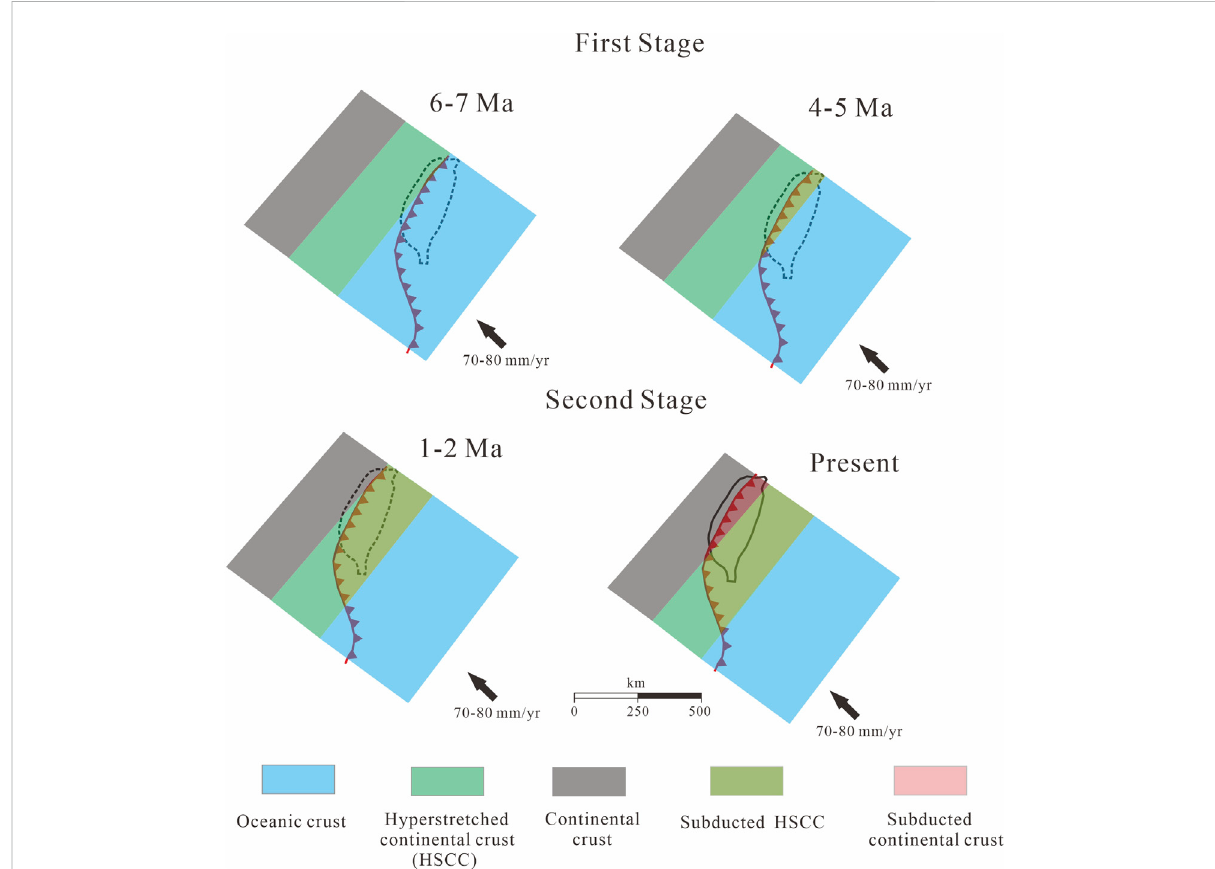
FIGURE 5 Evolution of the Taiwan accretionary prim since the Late Miocene. The location of the trench is derived from Deng et al. (2020) and the area of the HSCC is modi fi ed from Li et al. (2019). Owing to differences in orientation between the Manila Trench and the hyper-stretched continental crust (HSCC) ofthenorthernSouth ChinaSea, theamount ofHSCCsubductionchangesfromsouthto north andhas variedthroughtime.The subparallel trend between the trench and the continental margin supports simultaneous mountain building along the Taiwan orogenic belt during the fi rst stage of the Taiwan